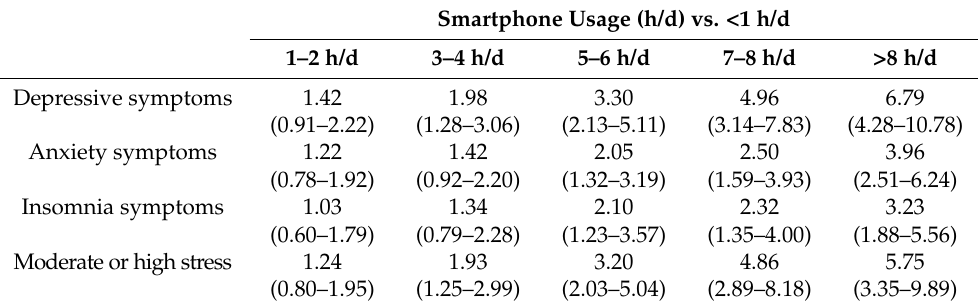
Table 2. Adjusted odds ratios and their 95% confidence intervals for different smartphone usage time categories vs. <1 h smartphone usage per day.